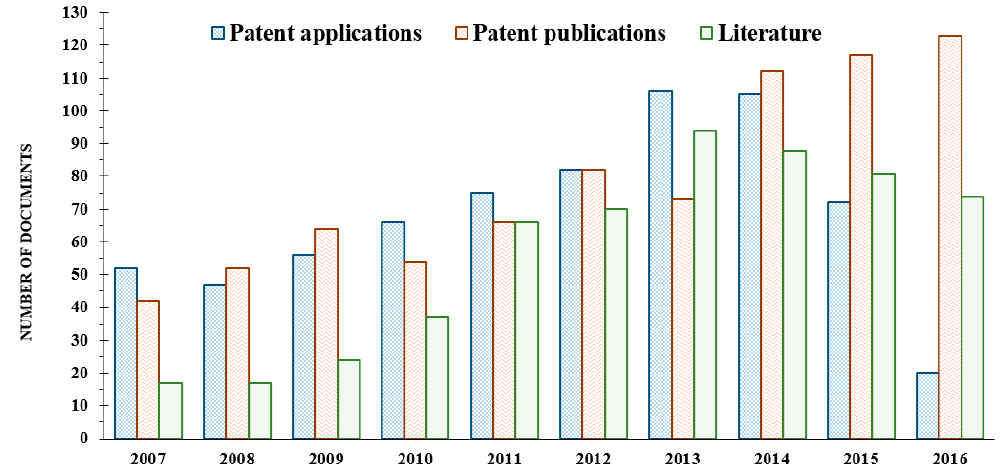
Figure 1. Evolution of the number of patent family applications and publications of Cooperative Patent Classification (CPC) Y02C 10/10 and scientific literature between 2007 and 2017.